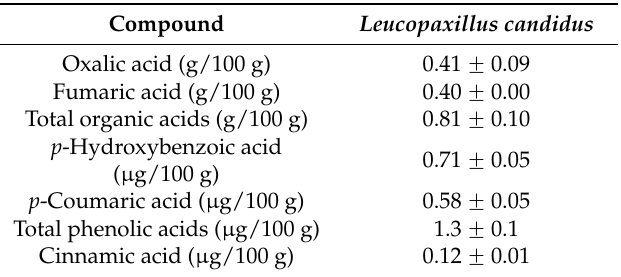
Table 2. Organic acids and phenolic compounds of the fruiting bodies expressed in dry weight basis (mean ˘